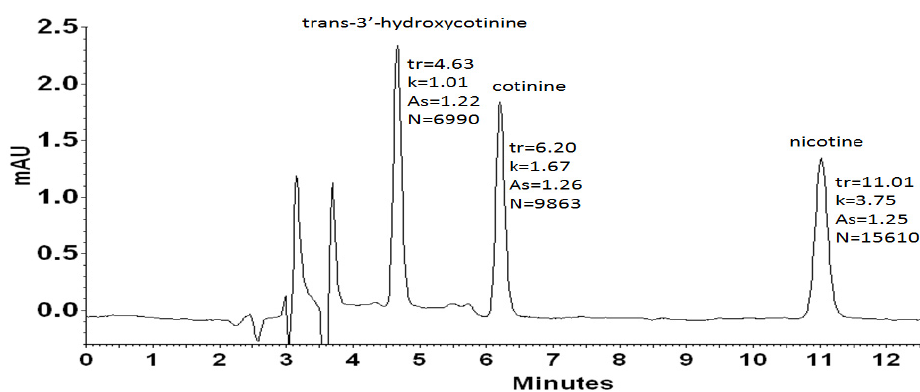
Figure 1. HPLC-DAD chromatogram obtained for solution of standards: trans -3 (cid:48) -hydroxycotinine (tr = 4.63 min), cotinine (tr = 6.16 min), nicotine (tr = 11.01 min) at the concentration level of 500 ng L − 1 . The analysis was performed using an Agilent 5 HC-C18(2) (250 × 4.6 mm I.D.) column. The mobile phase was acetonitrile (10%, v / v ), 20 mM phosphate buffer pH = 2.7 containing 30 mM NaPF 6 in the whole mobile phase. The DAD detection was set at 260